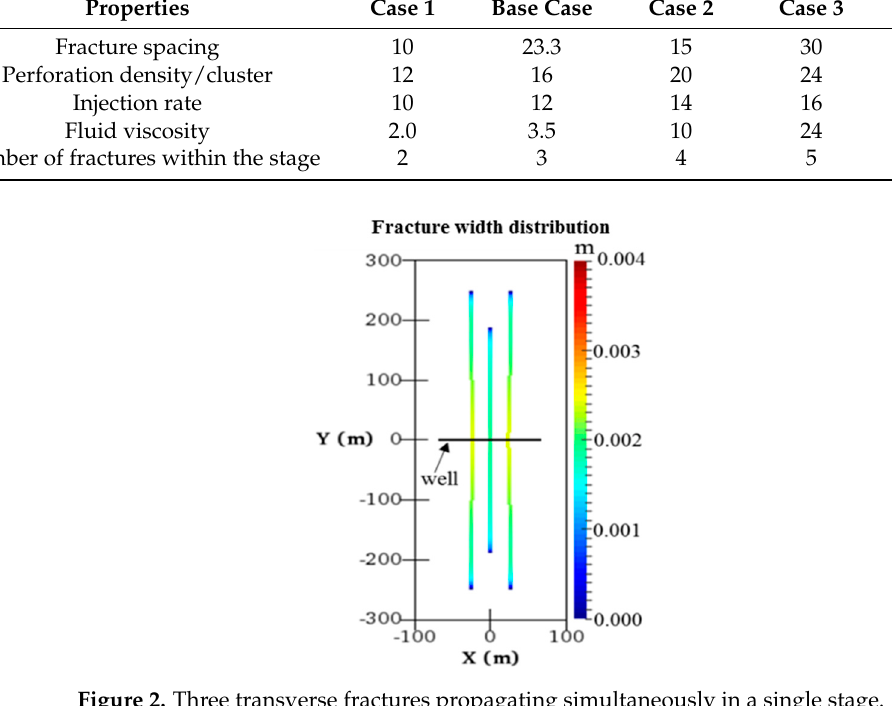
Figure 1. Three transverse fractures with a uniform spacing of 23.3 m in a single stage. Table 1. Input parameters for simulation cases in this study.